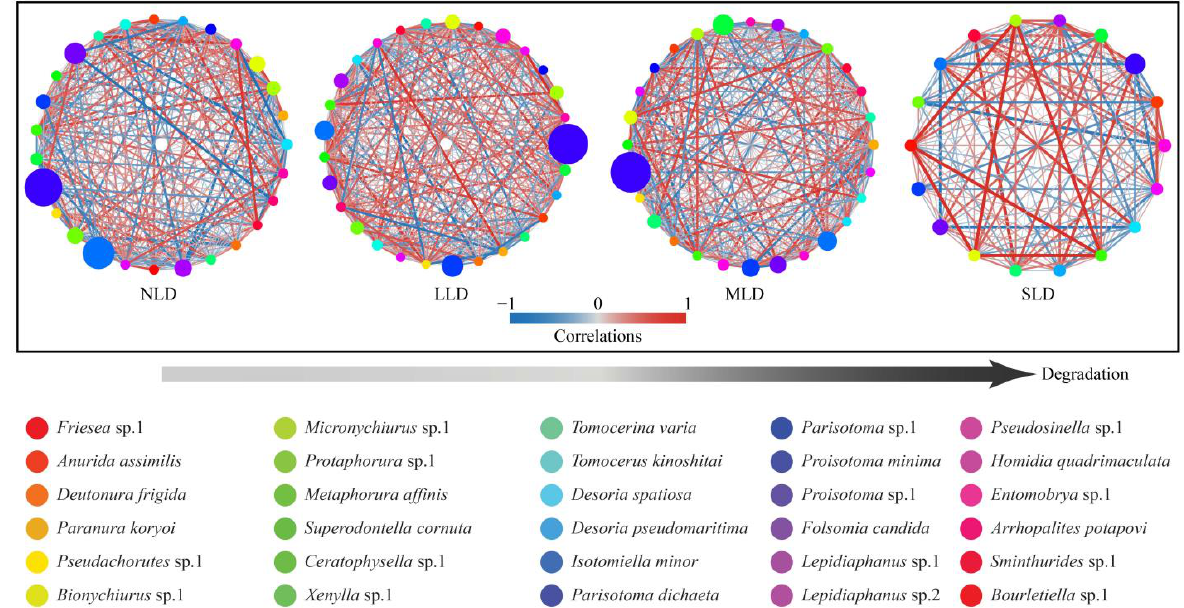
Figure 2. Network visualization of soil Collembolan community structure. The size of the circles represents the abundance of soil Collembolans, and the different colors represent different